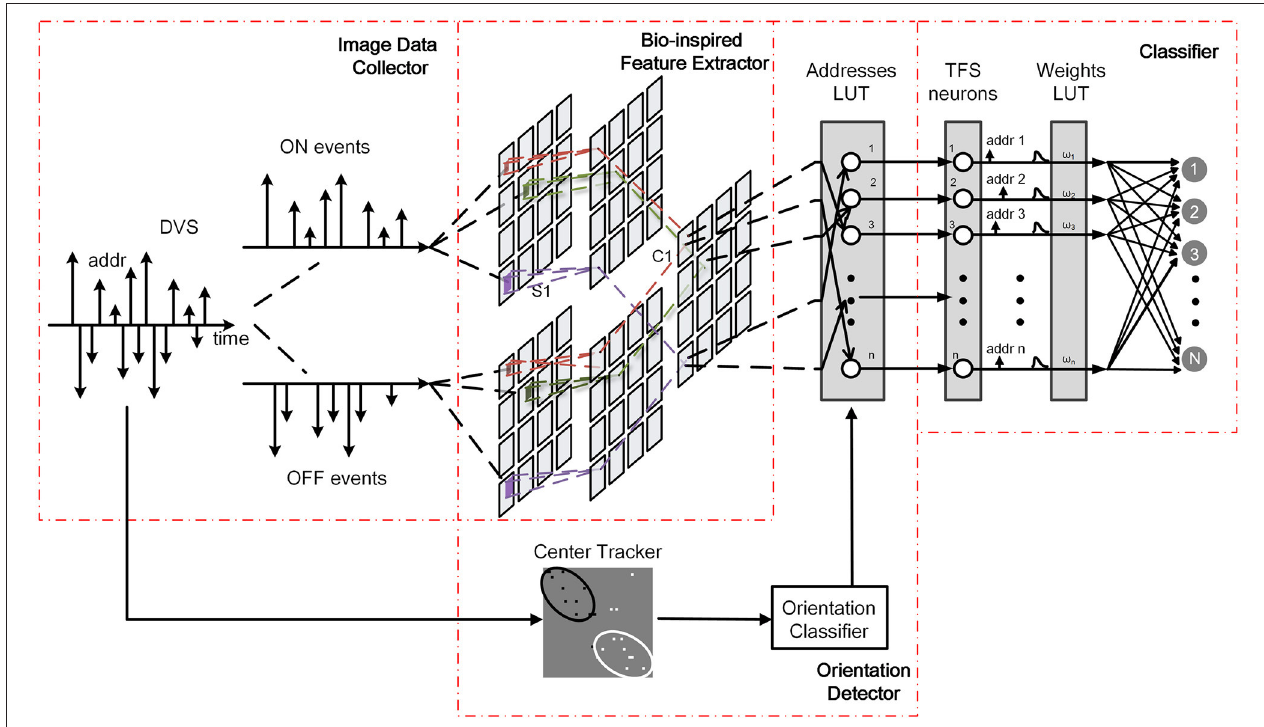
FIGURE 1 | Architecture of the proposed